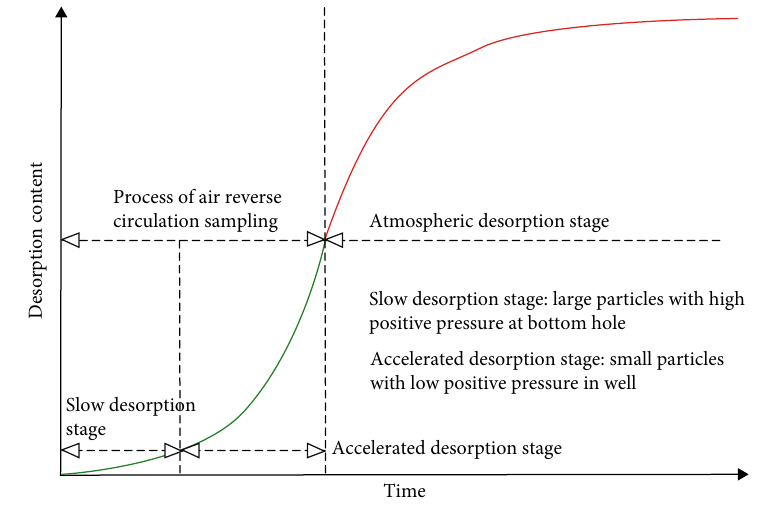
Figure 6: Sample desorption curve during ARCS.